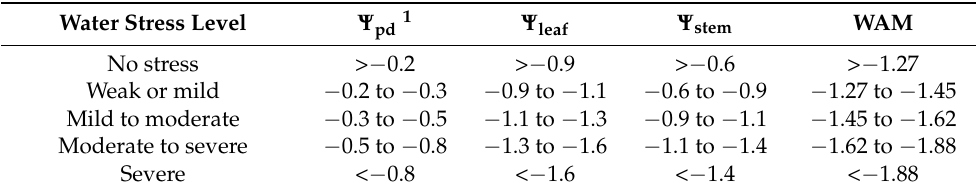
Table 1. Water potential values (MPa) with respect to vine water stress thresholds (adapted from